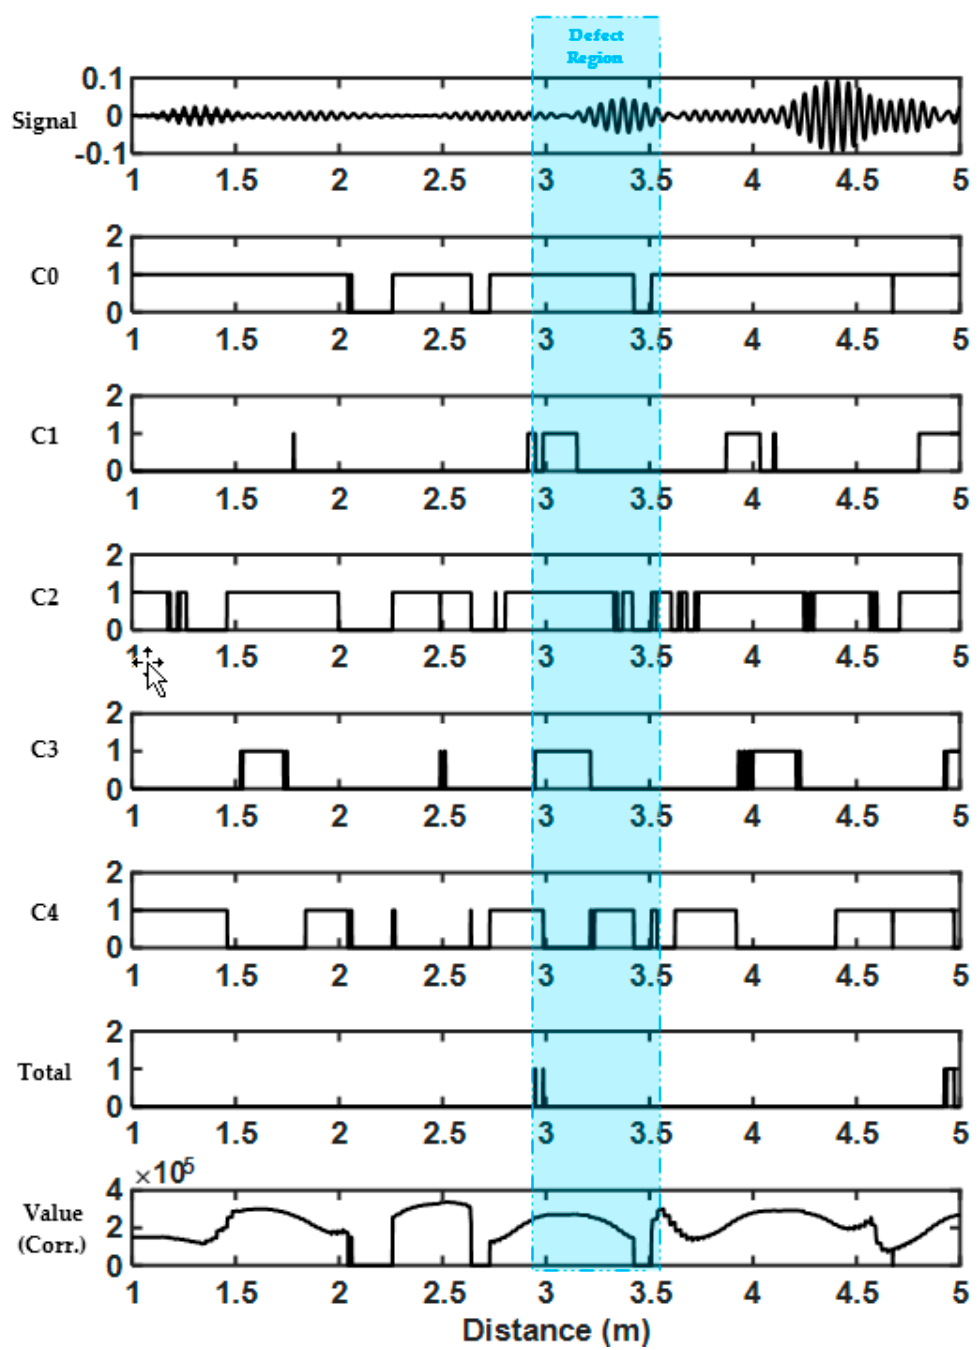
Figure 12. The generated results from the FEM test case.